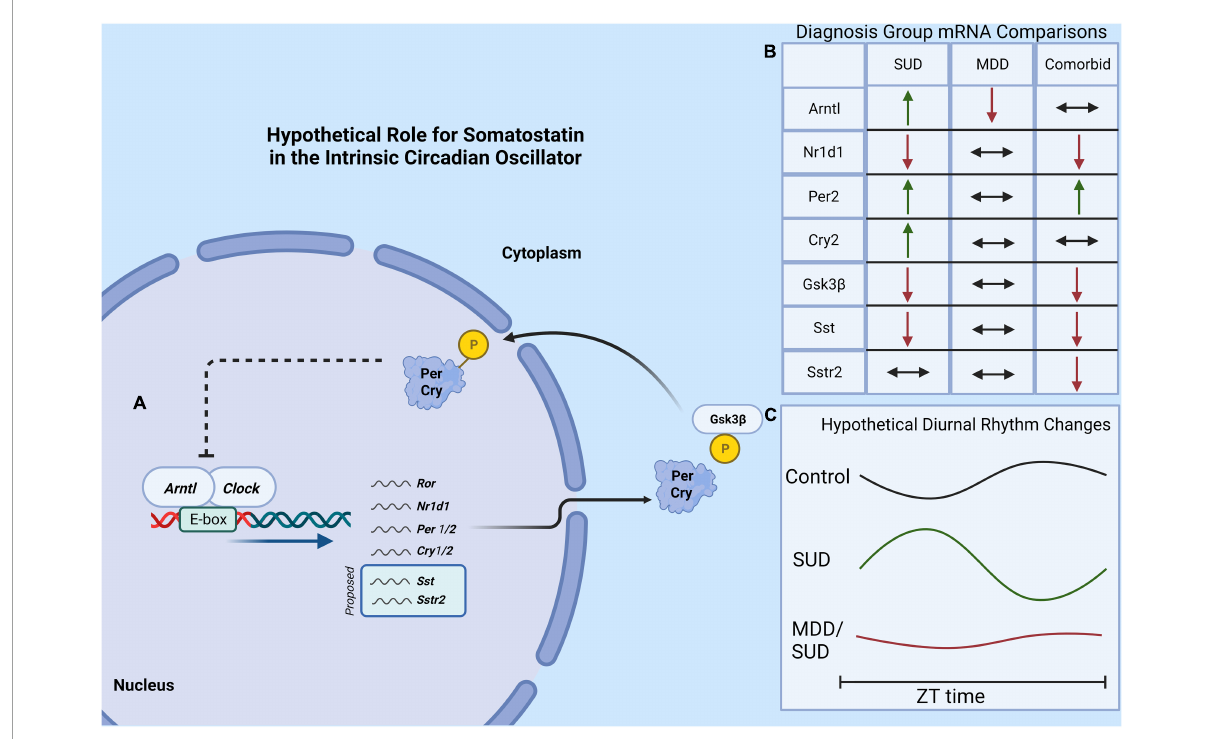
FIGURE8 Hypothetical model of molecular clock and SST signaling in SUD. (A) The core molecular circadian clock depicting the dimerization of Arntl and Clock genes which promotes the expression of several “clock-controlled genes” which may potentially include Sst and the Sstr2. (B) A summary of findings of diagnosis group differences in gene expression. (C) A hypothetical model showing altered clock gene rhythms in subjects with SUD and MDD/SUD, with amplified and shifted diurnal rhythms in SUD compared to dampened rhythms in the MDD/SUD